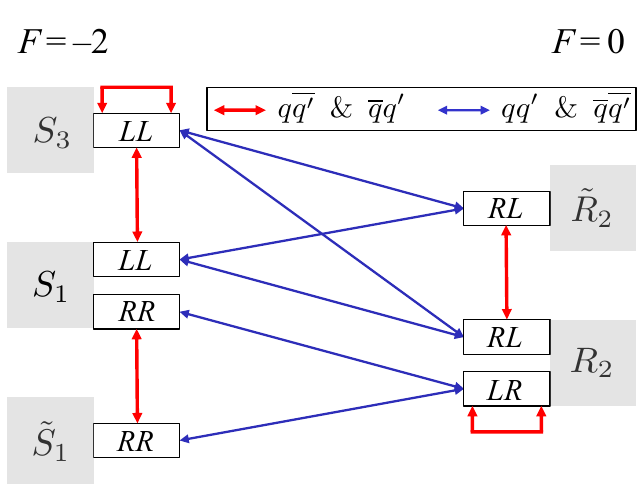
Figure 1 . Schematic classification of potential sources of asymmetric leptoquark pair production. See text for